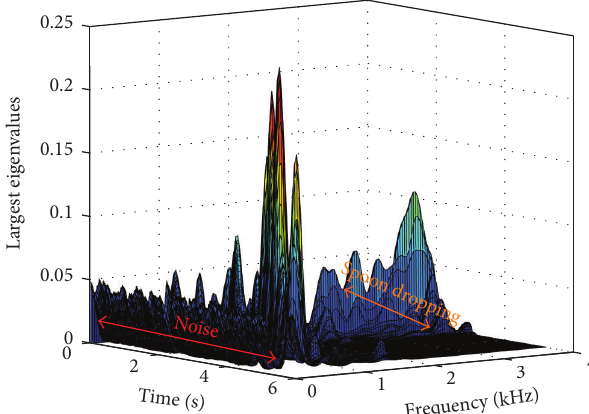
Figure 8: Time-frequency plot of the largest eigenvalues of the averagedcrossspectralmatricesforadroppingspoonsoundinradio noise.